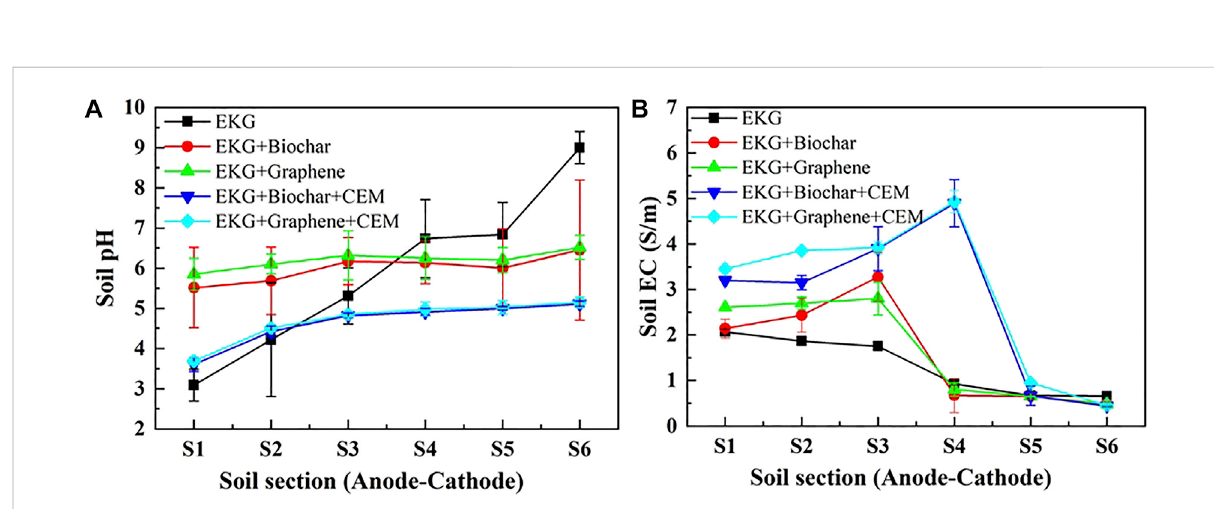
FIGURE 9 Variation of pH and EC after the electrokinetic experiment subjected to the effect of the different treatments: (A) pH and (B) EC.